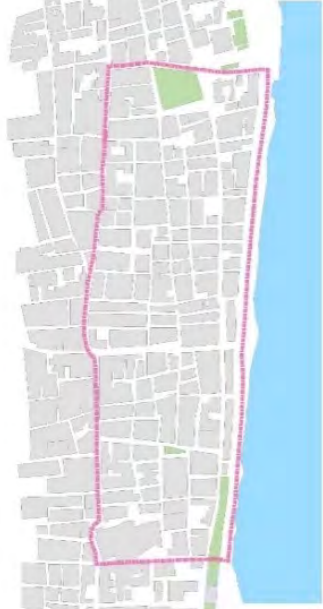
Figure 14. The heart of the center